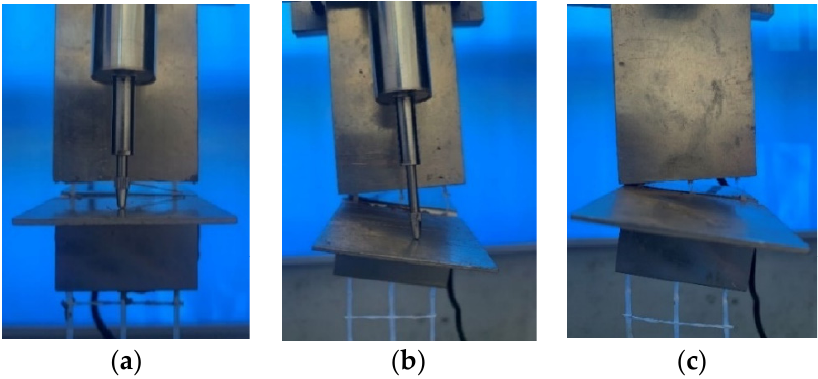
Figure 5. Failure mode: ( a ) pulling out, ( b ) compound mode, and ( c ) textile rupture.